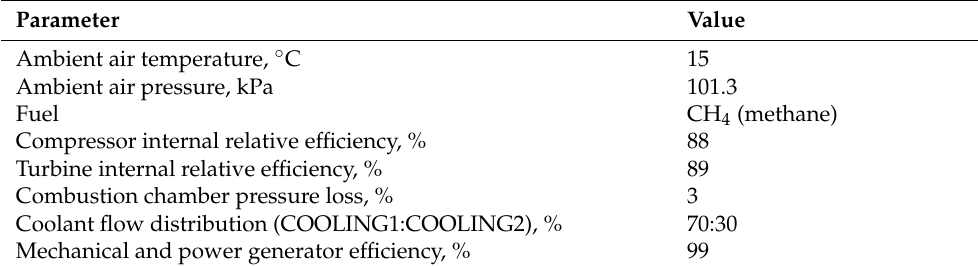
Table 2. GT modeling input